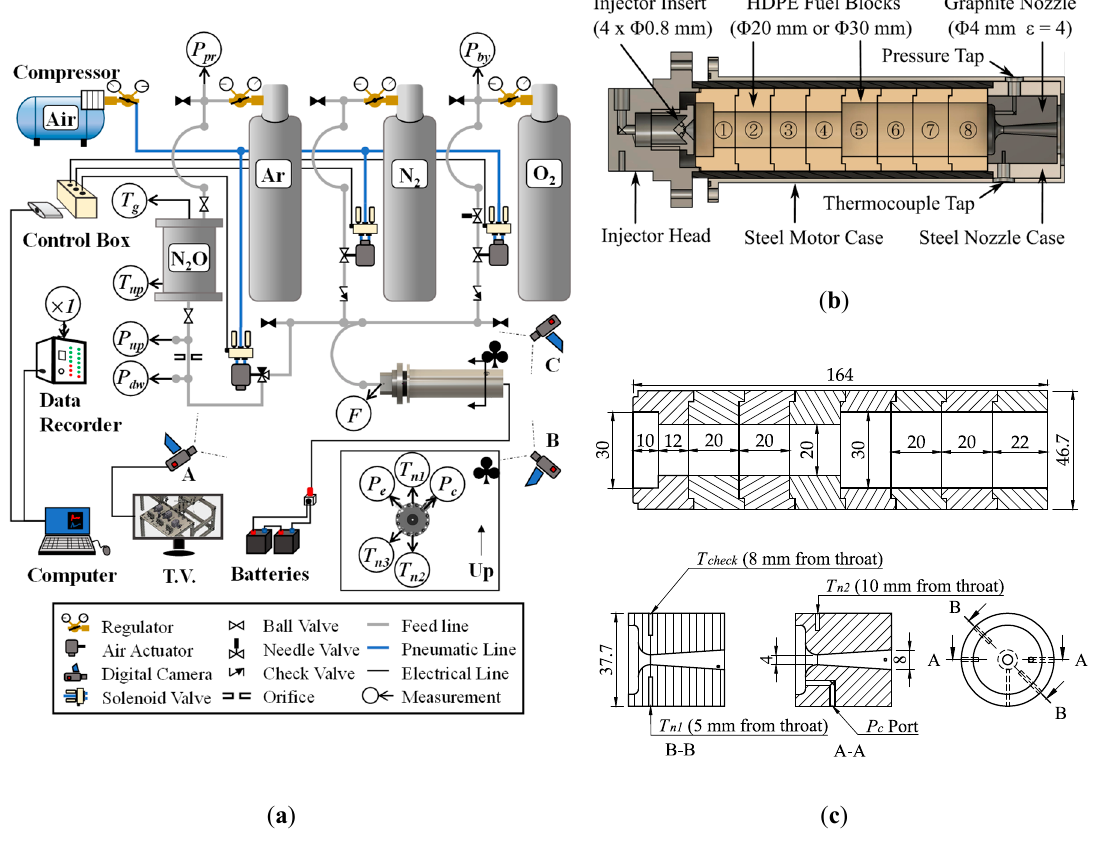
Figure 5. The experimental apparatus ( a ) test setup; ( b ) cut-away view of the motor assembly; ( c ) detailed schematics of the fuel grain and nozzle (units of mm).